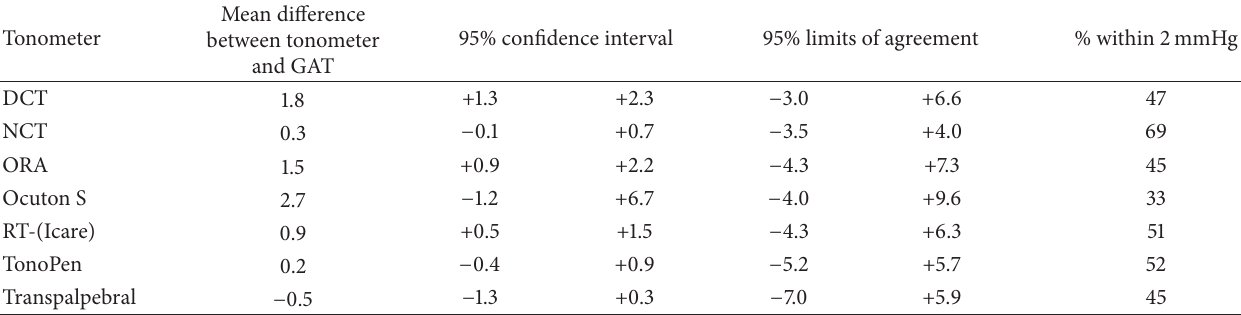
Table 2: Differences in IOP between different tonometers and Goldmann applanation tonometry